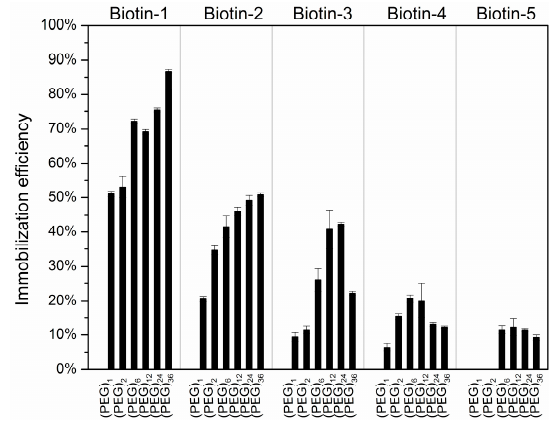
Figure 3. Immobilization efficiencies of biotinylated compounds on hexyl-isocyanate functionalized slide with spacers (PEG) n of varying lengths (n = 1, 2, 6, 12, 24, 36).